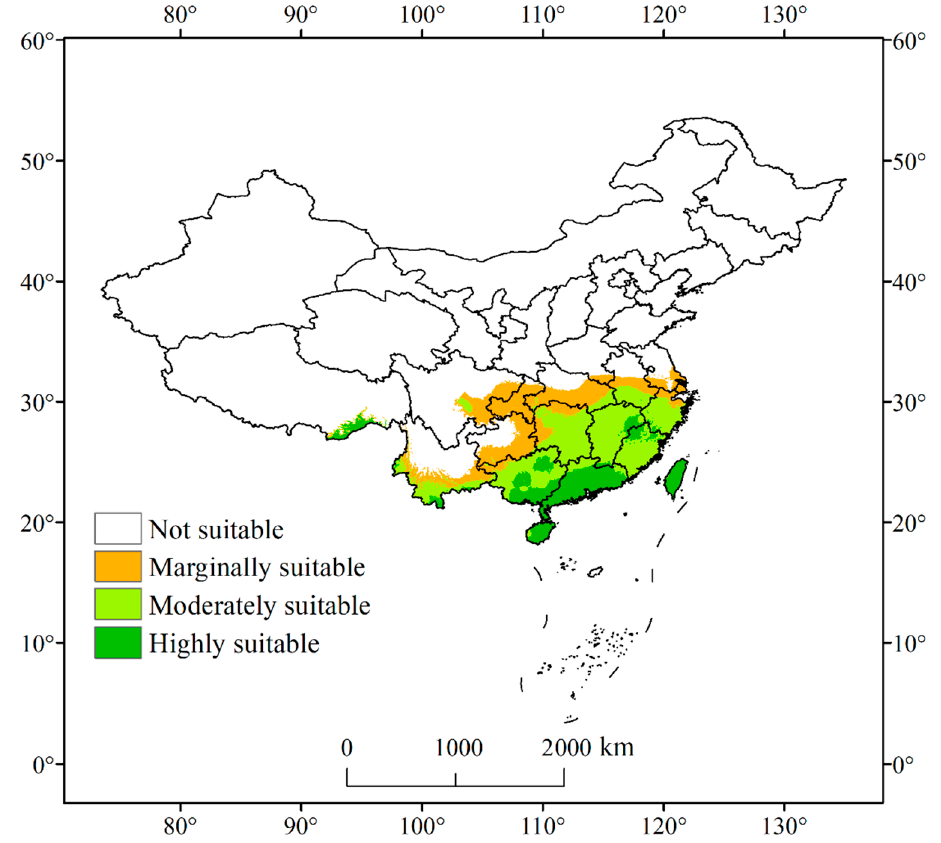
Figure 2. Predicted current distribution model by Maxent. Orange refers to marginally suitable habitat; light green refers to moderately suitable habitat; dark green refers to highly suitable habitat; blank refers to not suitable areas.